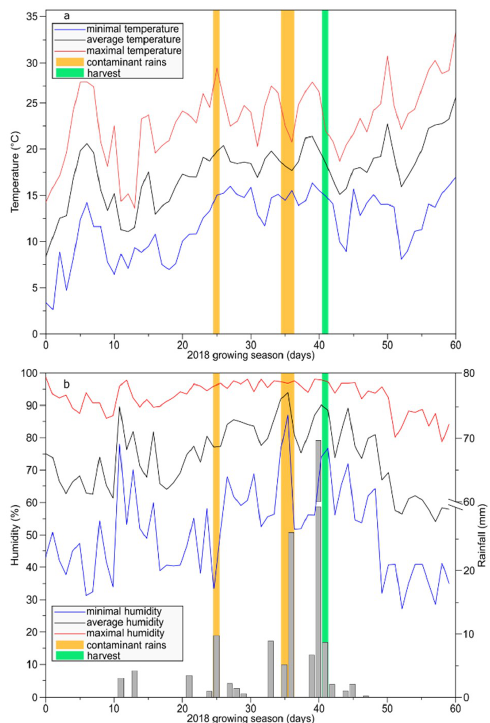
Figure 7. Vineyard climatic conditions during May and June 2018. ( a ) Temperature. ( b ) Humidity. Yellow bars: days of contaminant rains (26 May and 5–6 June 2018). Green bar: day of leaf harvest (11 June 2018).